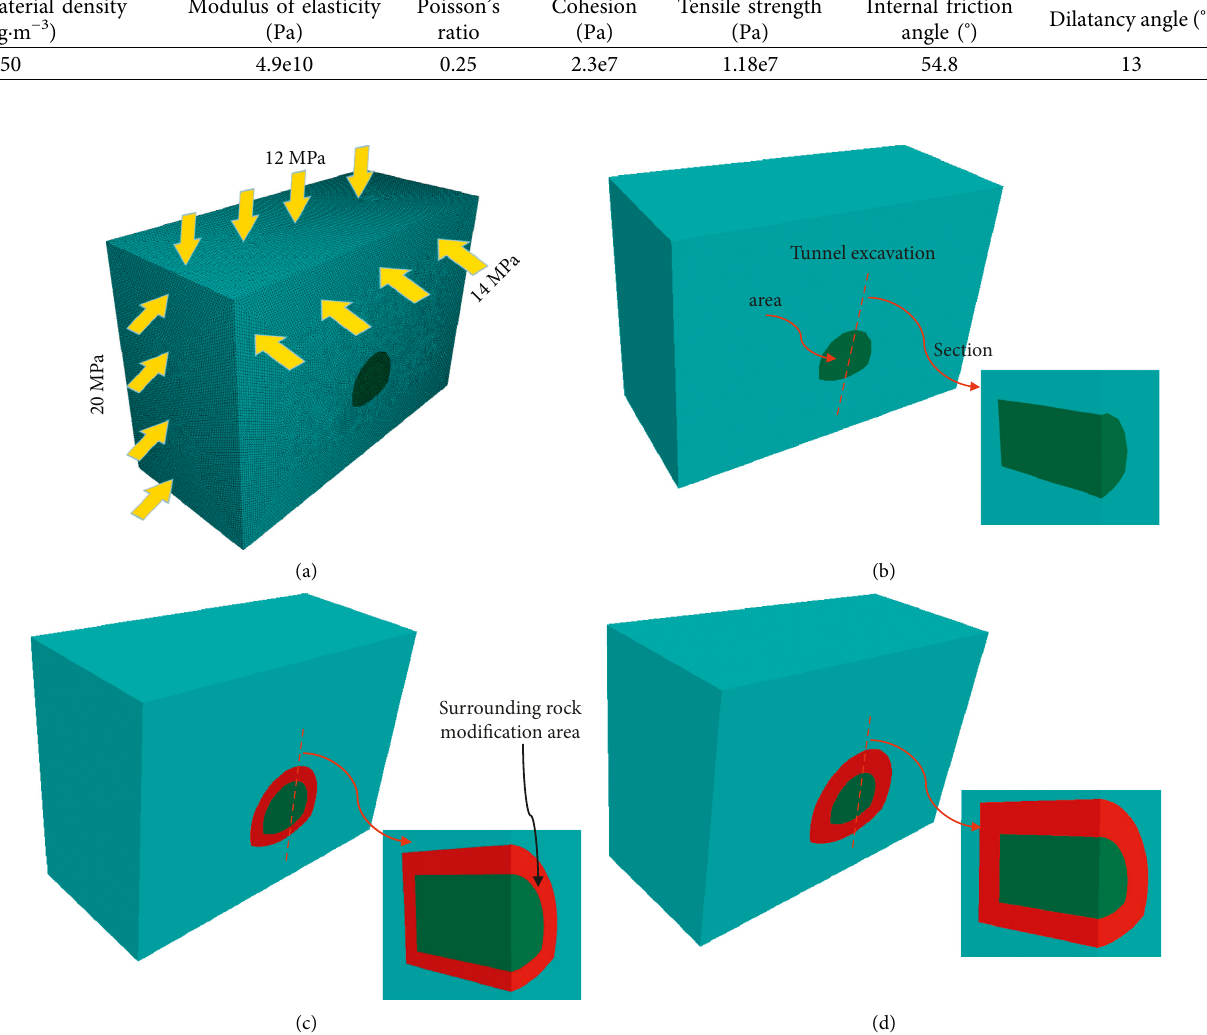
Figure 5: Numerical calculation model. (a) Model stress boundary conditions. (b) Tunnel excavation without surrounding rock modi- fication. (c) The modified depth of surrounding rock during tunnel excavation is 3m. (d) The modified depth of surrounding rock during tunnel excavation is 5m.